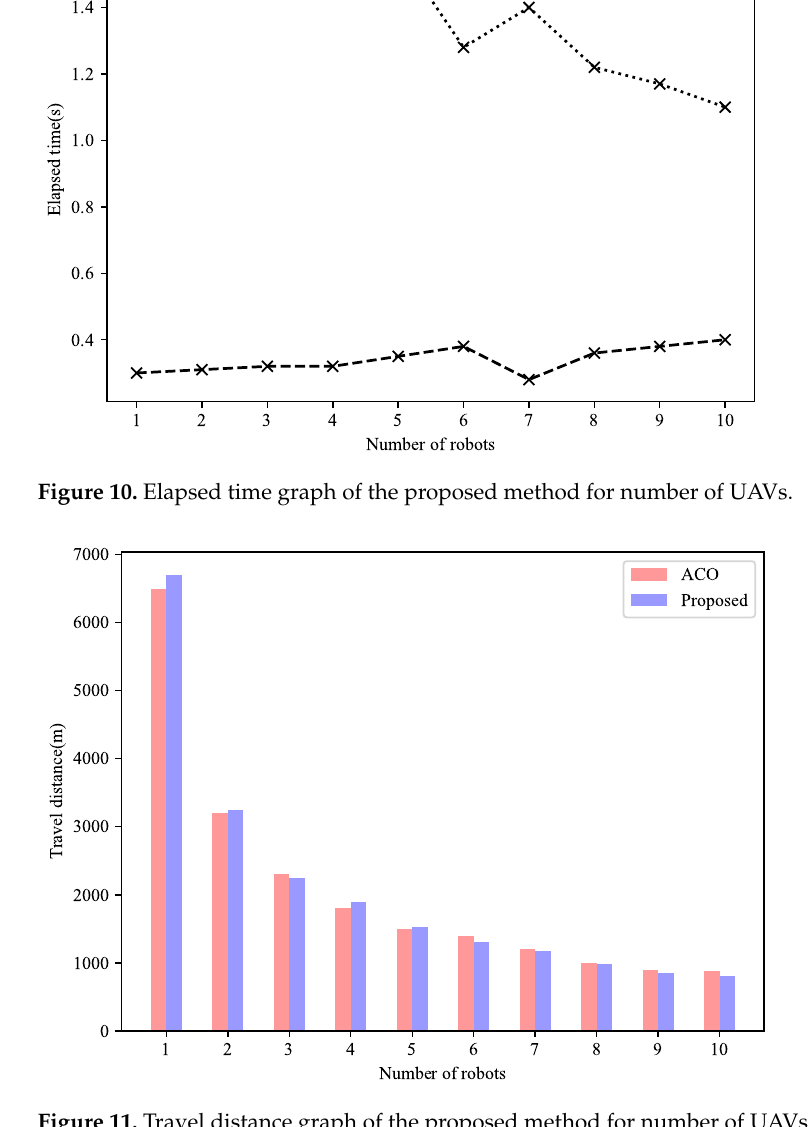
Figure 11. Travel distance graph of the proposed method for number of